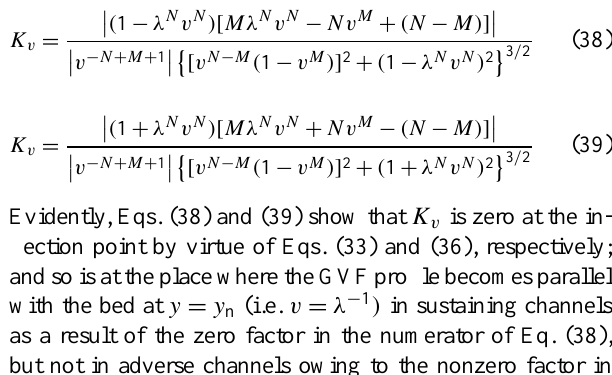
Fig. 5. Plot of the curvature, K v , at v = 1 against y c / y n with the N